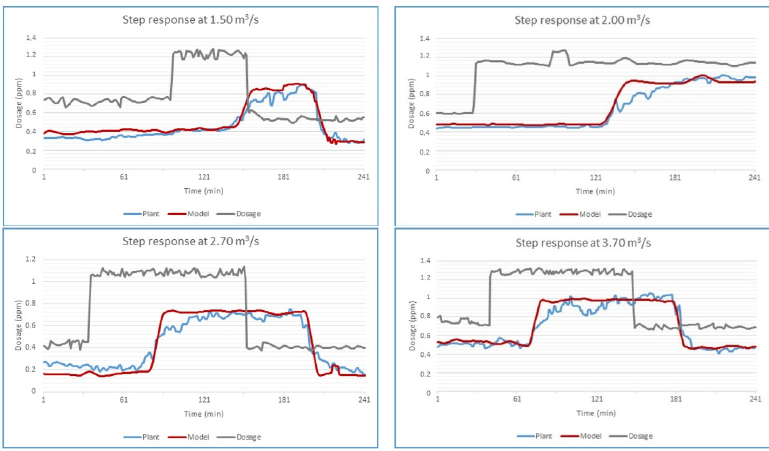
Figure 13. Data comparison between real data from SCADA and simulator data for different flow rates (1.5, 2.0, 2.7, and 3.7 m 3 /s).